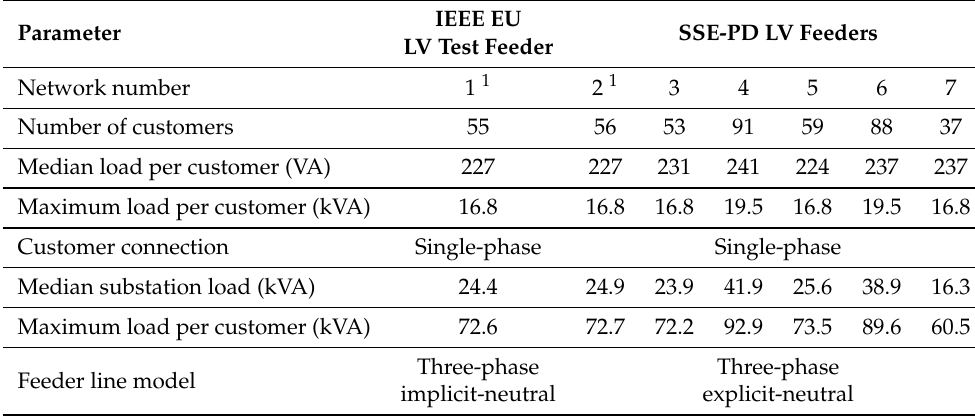
Table 4. Network model